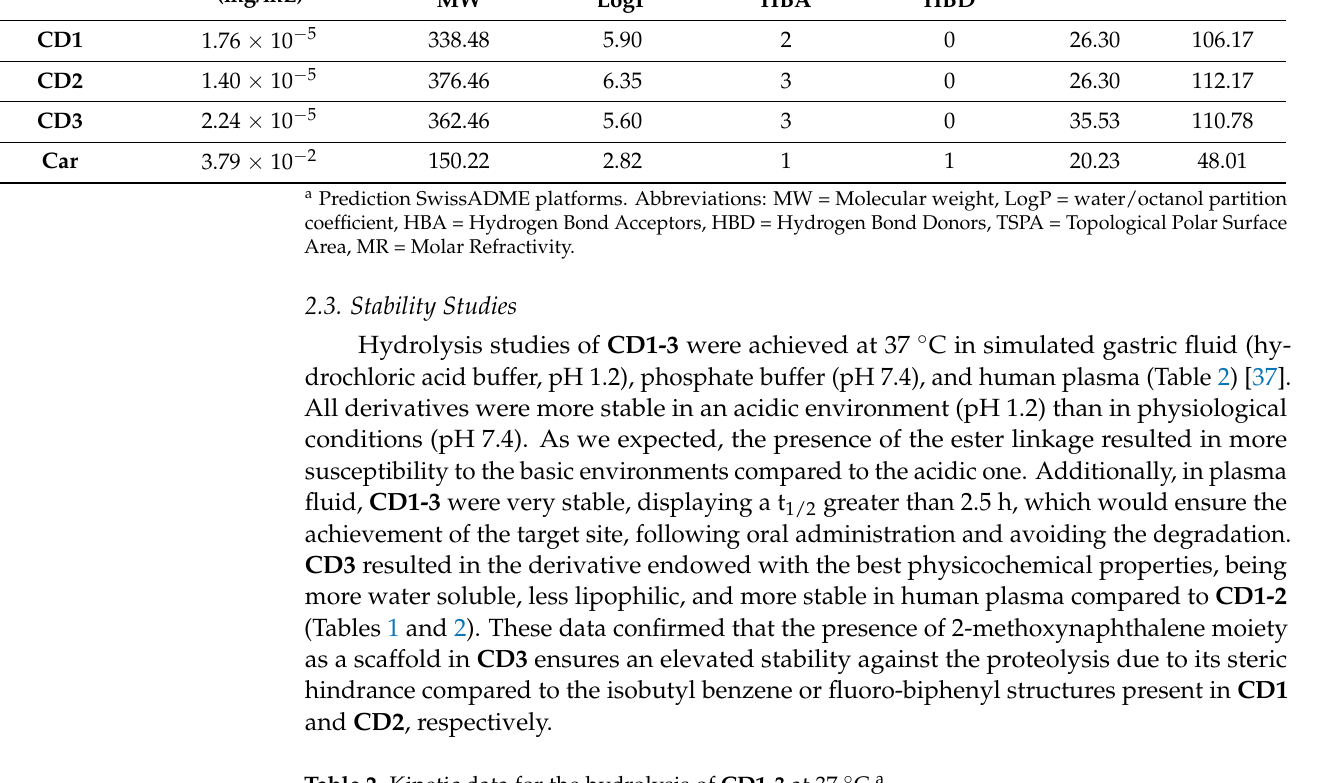
Table 2. Kinetic data for the hydrolysis of CD1-3 at 37 ◦ C a